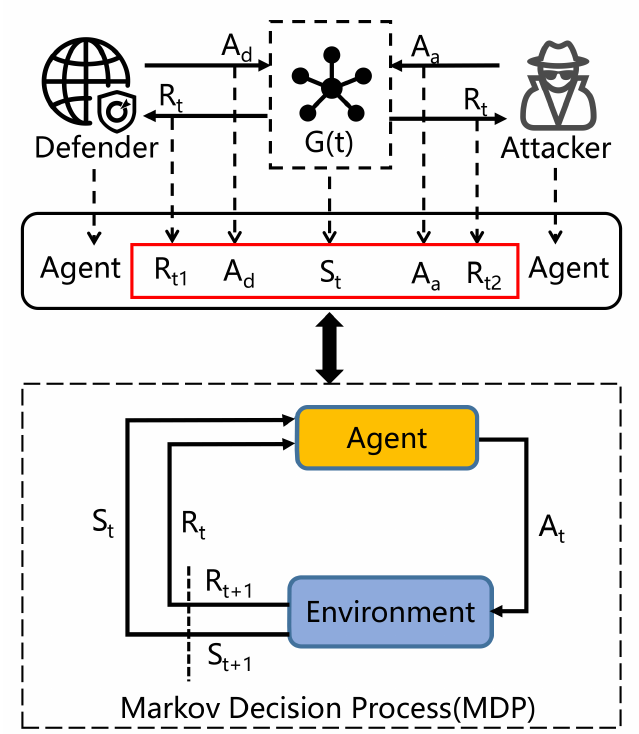
Figure 7. The penetration test process is modeled as MDP.